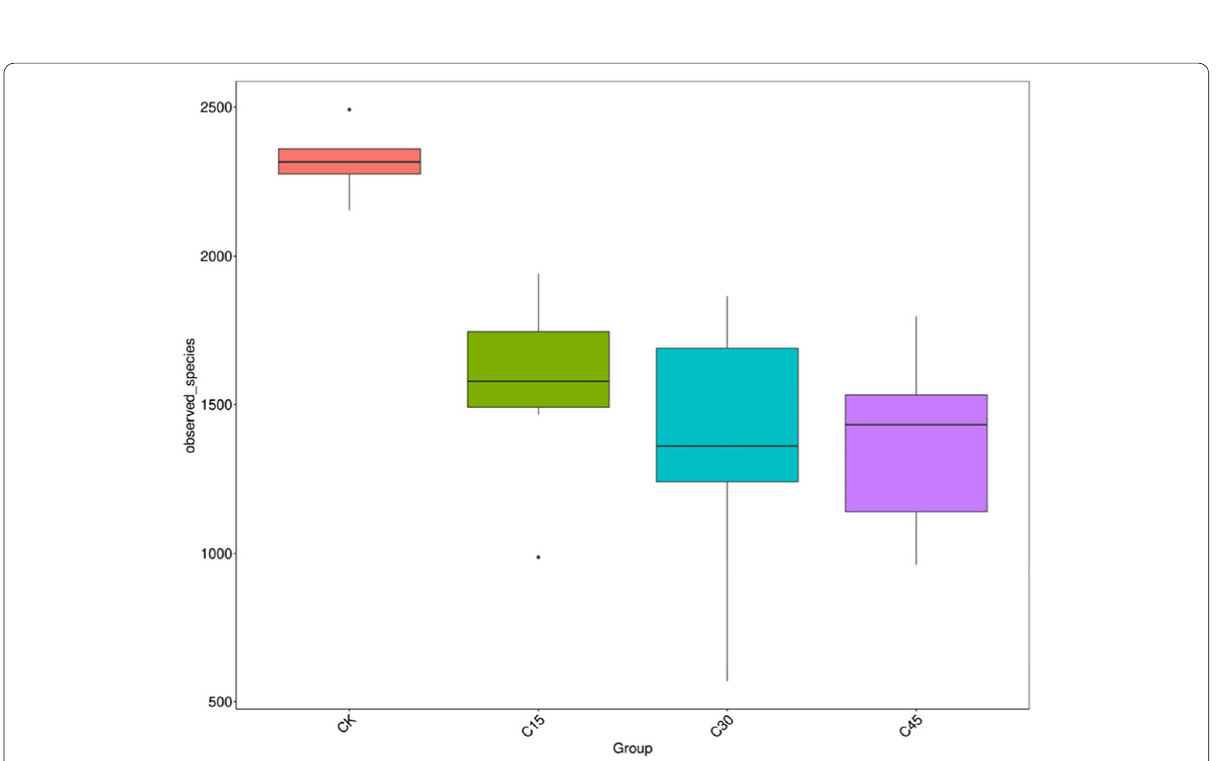
Fig. 3 Soil microbial α-diversity under different oil pollution